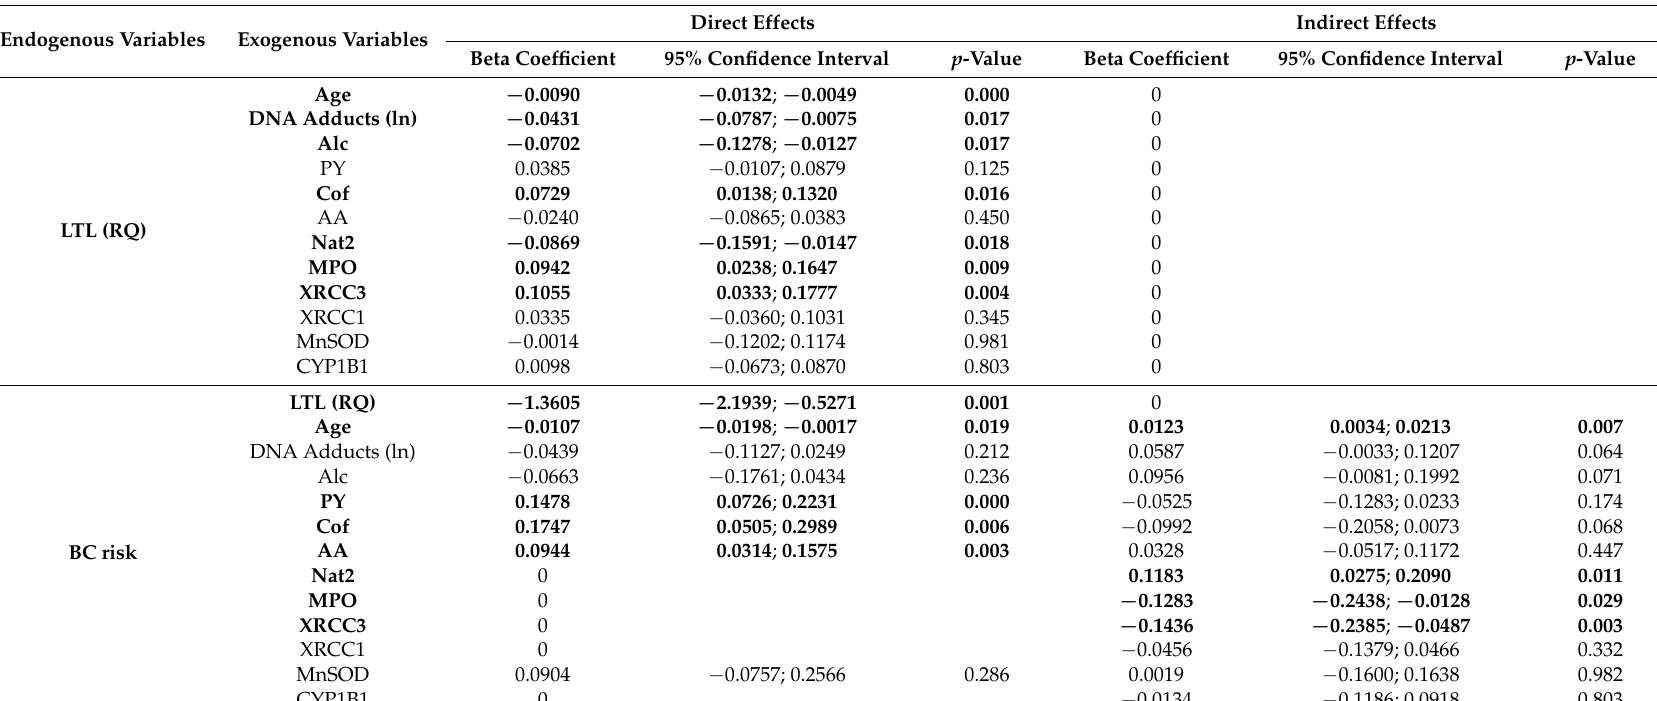
Table 2. SEM results (beta coefficients, 95% confidence intervals and p -values) for endogenous variables of structural equations: direct and indirect effects. Endogenous